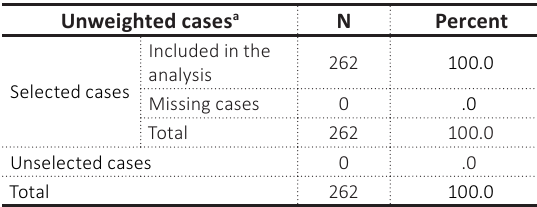
Table 4. Missing data identification test